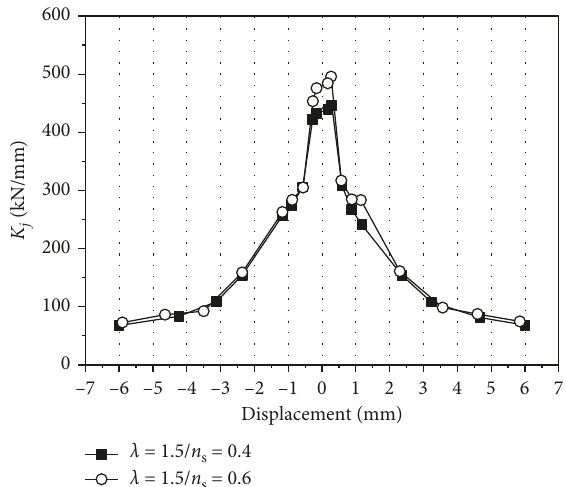
Figure 23: Stiffness degradation curves of the ISSCC columns under different axial compression ratios.